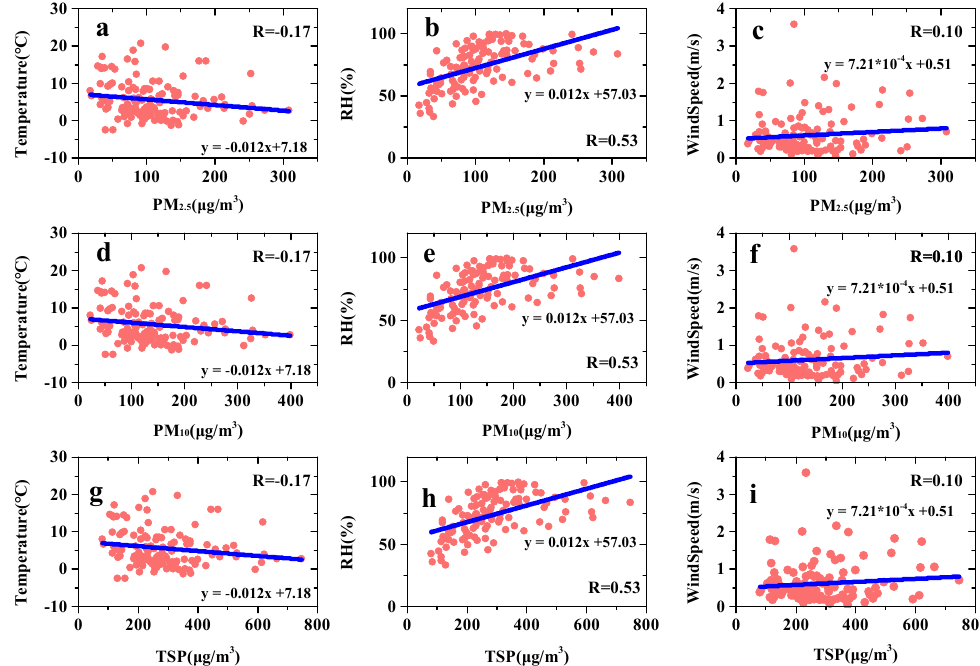
Figure 6. Correlation analysis of PM 2.5 , PM 10 , TSP, and meteorological elements during the experi- mental cycle: ( a ) PM 2.5 and temperature; ( b ) PM 2.5 and humidity; ( c ) PM 2.5 and wind speed; ( d ) PM 10 and temperature; ( e ) PM 10 and humidity; ( f ) PM 10 and wind speed; ( g ) TSP and temperature; ( h ) TSP and humidity; ( i ) TSP and wind speed.